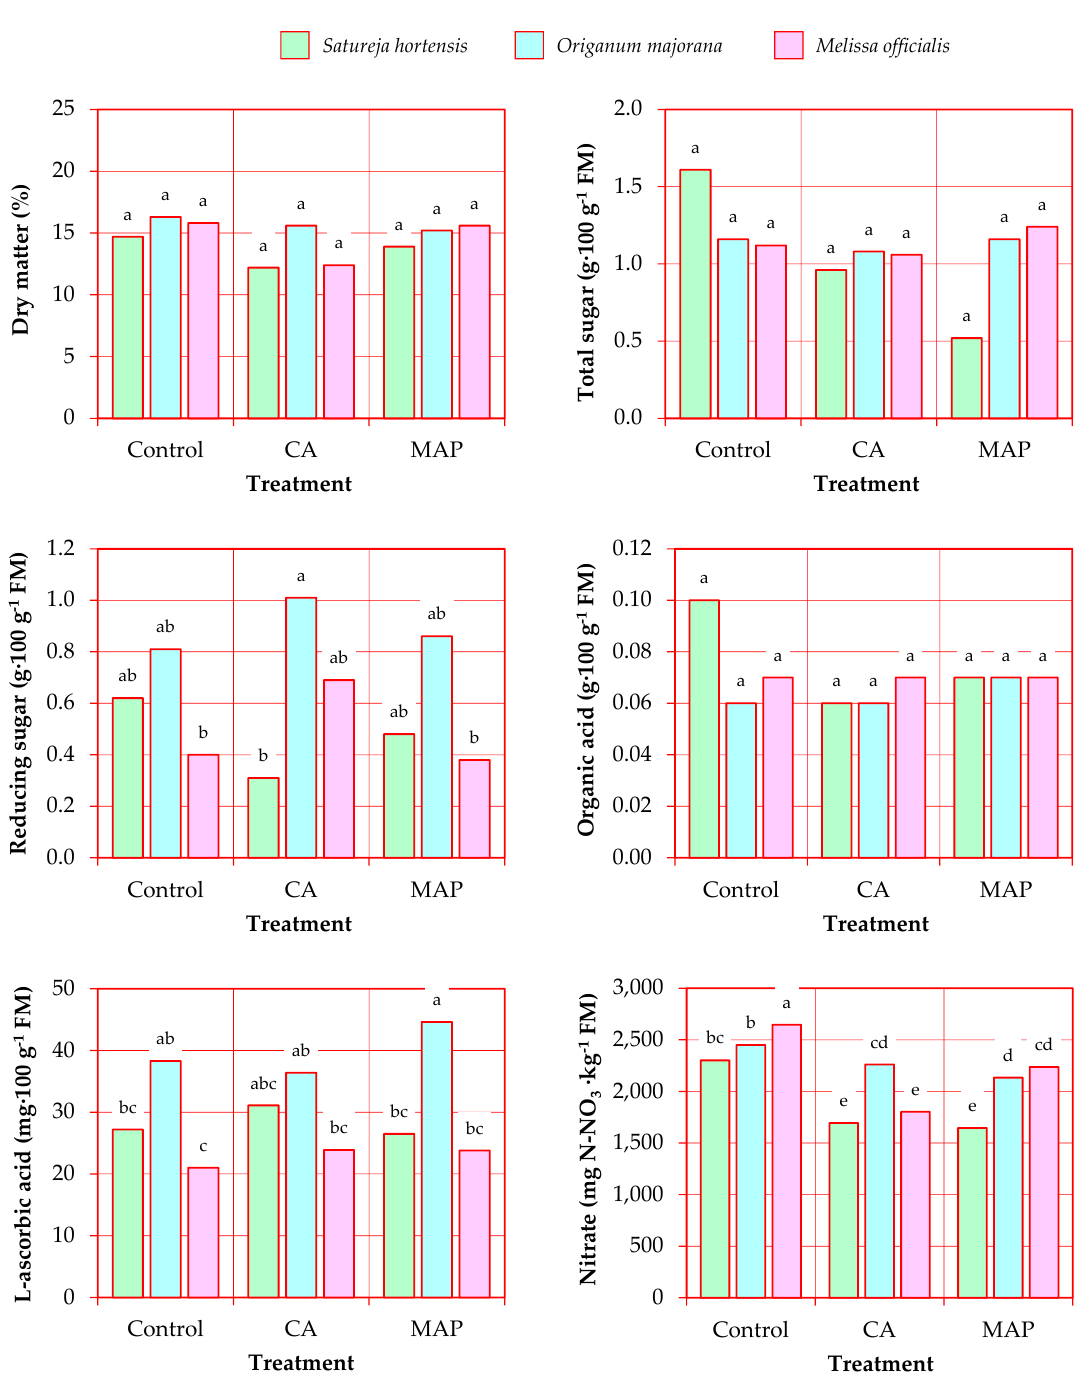
Figure 2. Effect of biostimulants on the nutrient composition of herbage in the analyzed herb species: a–e—various letters denote significant differences at p < 0.05 (Tukey’s test); CA—application of Calleaf Aminovital; MAP—application of Maximus Amino Protect. According to Fr ˛aszczak et al. [33], the concentration of L-ascorbic acid in herbs is significantly affected by the species and cultivation method. In the present study, marjoram was characterized by the highest concentration of L-ascorbic acid (39.7 mg 100 g − 1 FM on average). The L-ascorbic acid content of the herbage was not significantly modified by the biostimulants. The concentration of L-ascorbic acid increased in marjoram treated